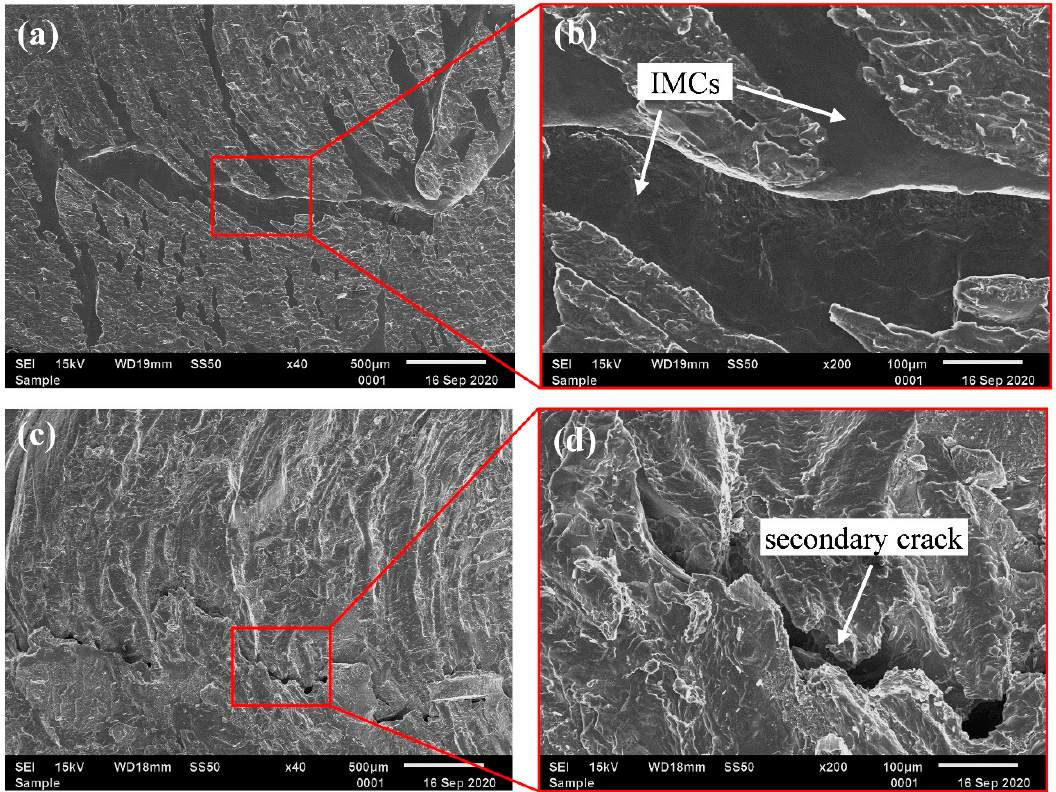
Figure 14. Fracture morphologies of the joints welded in different lap configurations at 700 rpm: ( a ) Configuration Al-Mg; ( b ) magnified micrograph of ( a ); ( c ) Configuration Mg-Al; ( d ) magnified micrograph of ( c ).